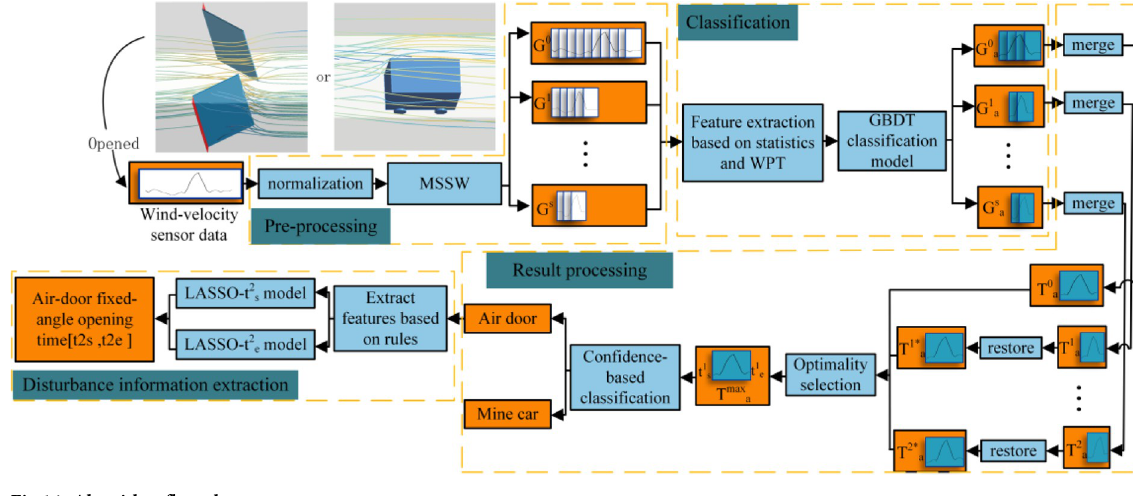
Fig 14. Algorithm flow